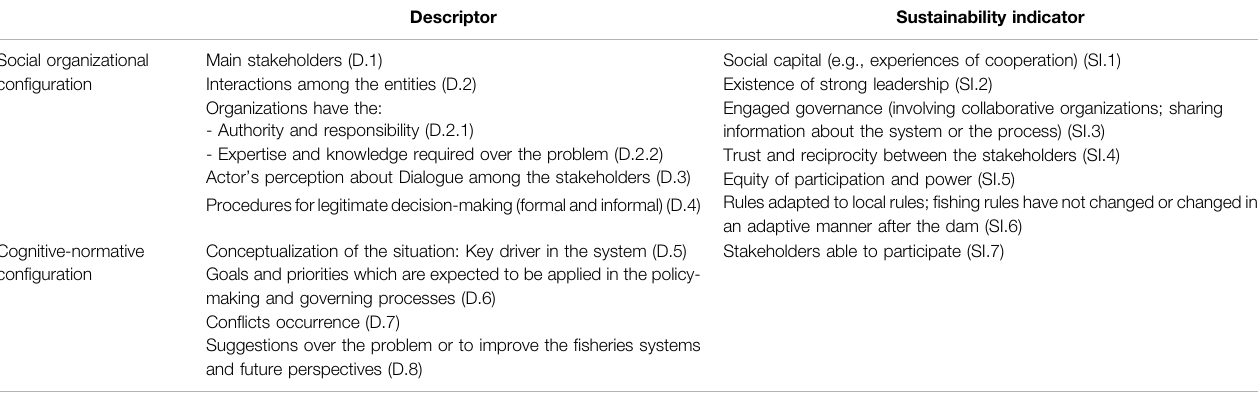
TABLE 1 | Theoretical framework used to describe the Governance architecture of the Fisheries System and their sustainability, modi fi ed from Agrawal and Ostrom (2001), Burns and Stöhr (2011) and Berkers and Ross (2013).